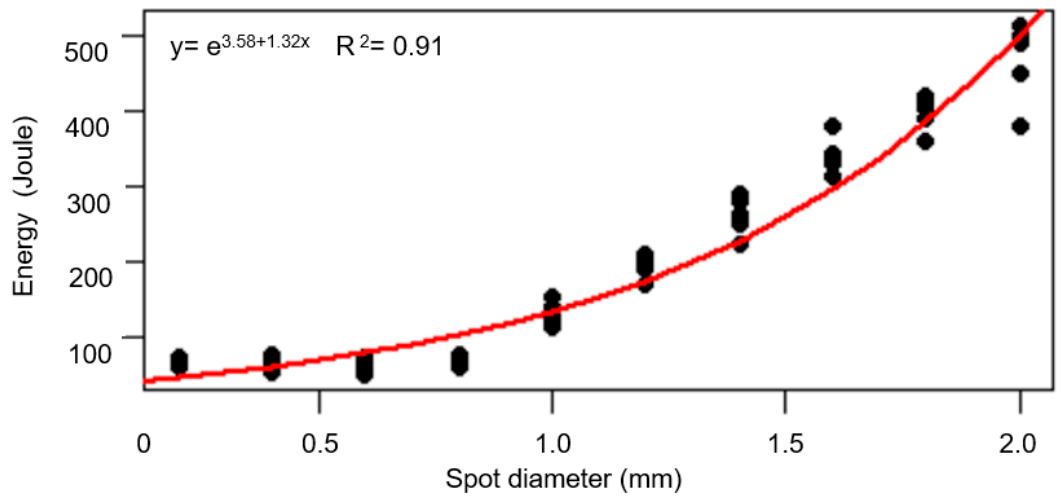
Figure 14. The relationship between the energy consumption and the diameter of the laser spot (mm). The larger the laser spot diameter has to be to damage a shoot of E. repens , the more energy is needed.